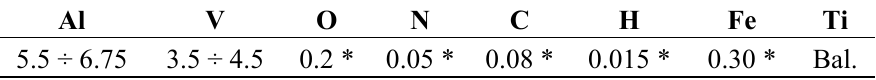
Table 10. Chemical composition of Ti6Al4V (wt%), * Max.